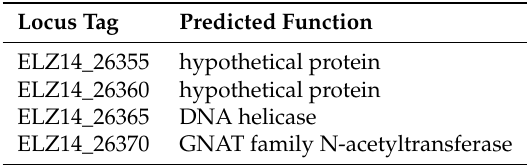
Table 4. Annotation of P. brassicacearum 3Re2-7 singleton